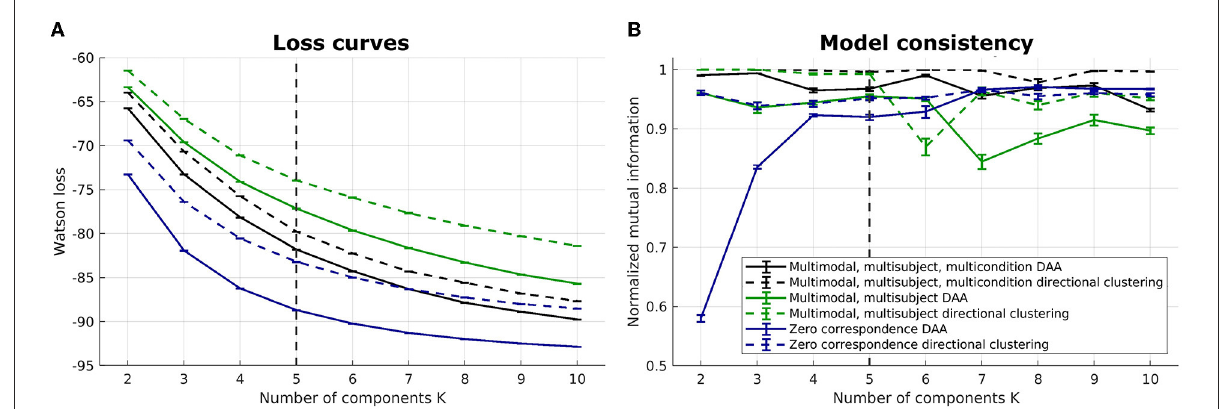
FIGURE4 Loss curves and NMI for multimodal, multisubject DAA and directional clustering models. (A) loss curves for the six models, including multimodal, multisubject, multicondition DAA, a model where the three conditions are concatenated in time to enforce equal archetypes, and a model modeling all subjects separately with no correspondence between subjects. Error bars represent standard error of the mean. (B) NMI to inform on model consistency. Both loss curves and NMI are evaluated on 5 model fits for each model, each being the best of 100